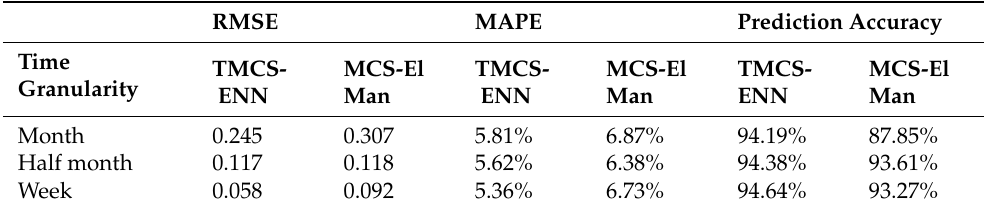
Table 4. Comparison of the results under different time